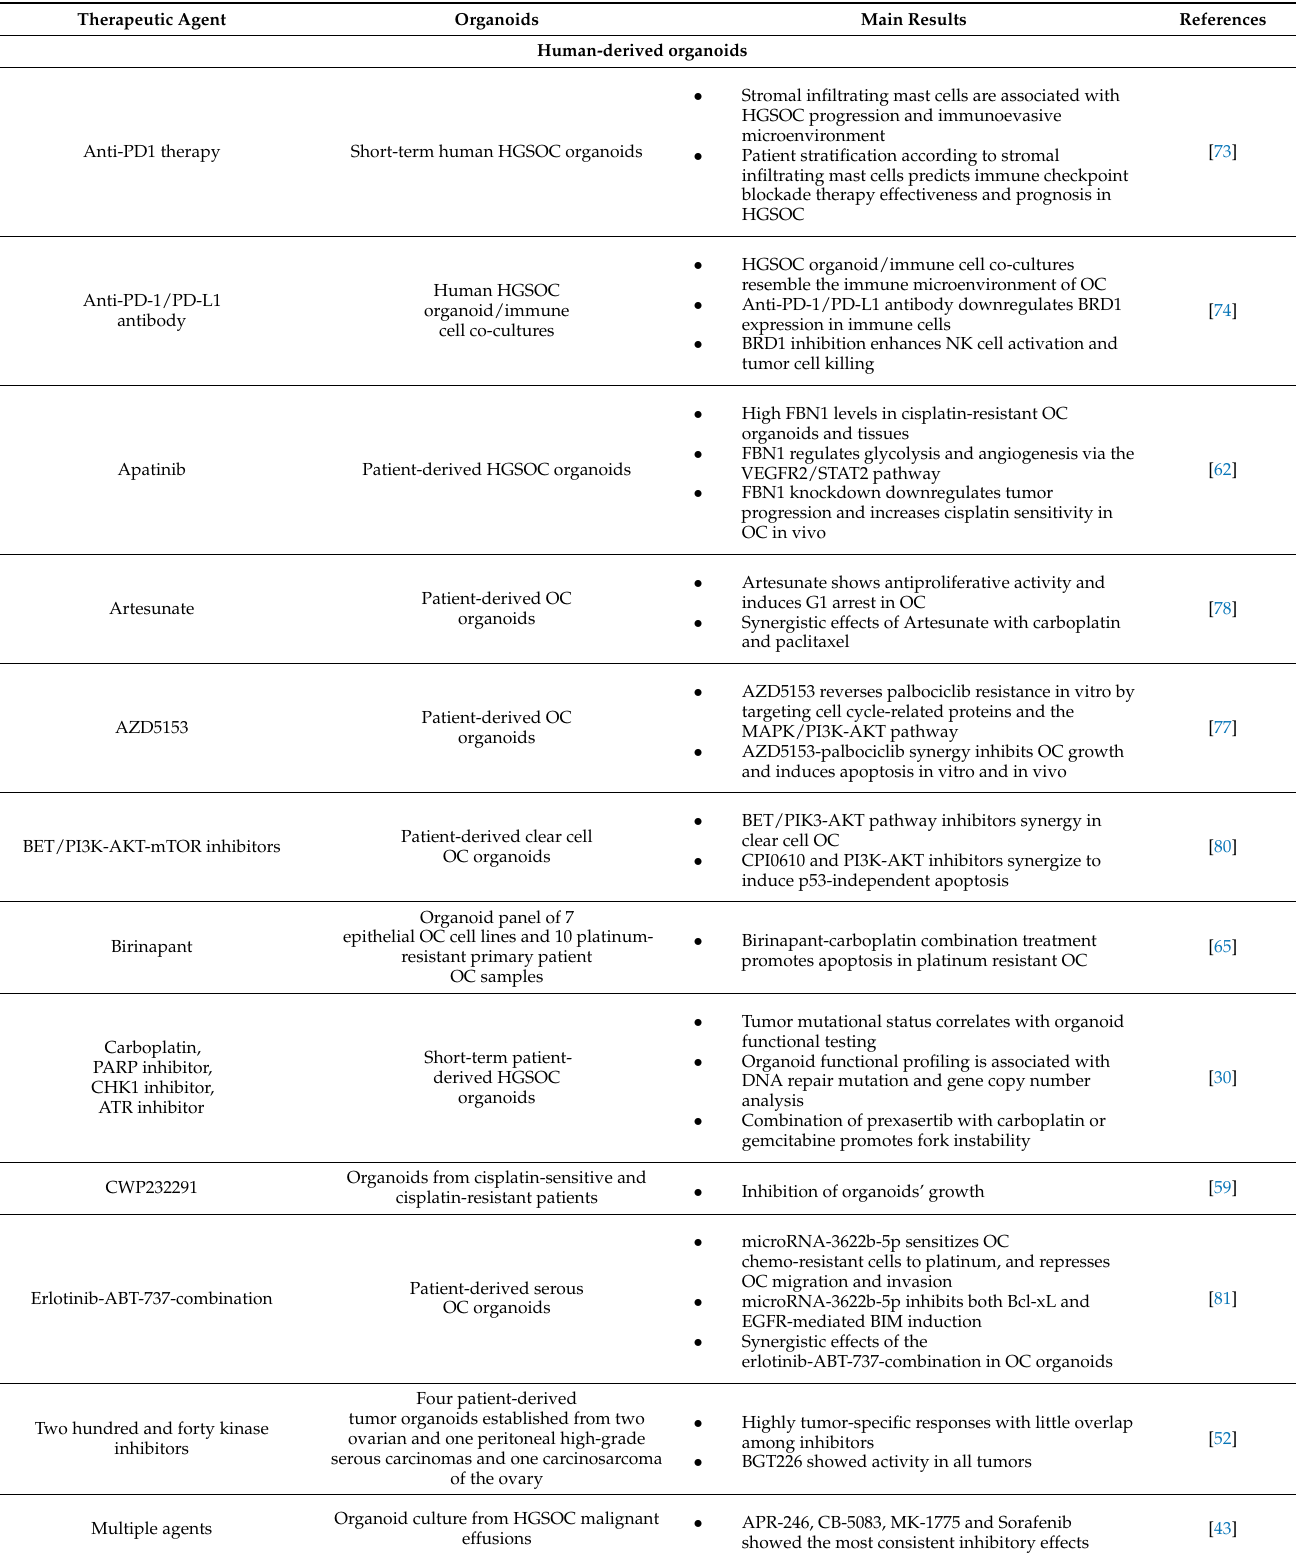
Table 4. The use of organoids for disease modeling and targeted therapy sensitivity